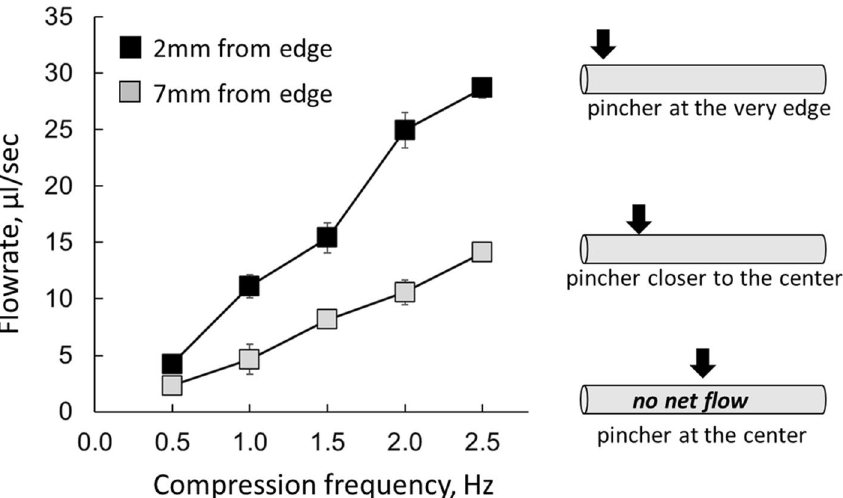
Figure 4. The flowrate–pincher position relationship. For all tested conduits, the maximal flow rates were observed when the pincher was at the very edge (i.e., the position closest to the junction between the compliant tube and the connector). No net flow was observed when pincher was located in the middle of the tube. The values shown in this graph were acquired using a 27-mm-long, 5-mm-wide compliant segment with a wall thickness of 0.4 mm with the loop filled with aqueous solution. The data shown are for the two pincher positions—2 mm and 7 mm from the junction between the stiff and compliant segments.